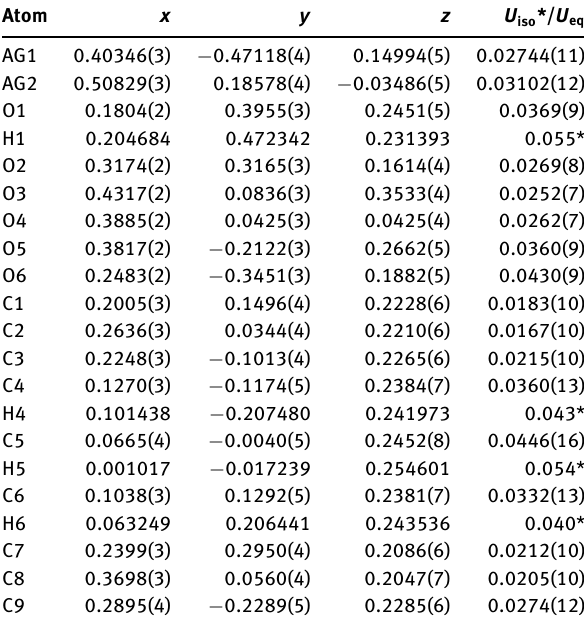
Table 2: Fractional atomic coordinates and isotropic or equivalent isotropic displacement parameters (Å 2